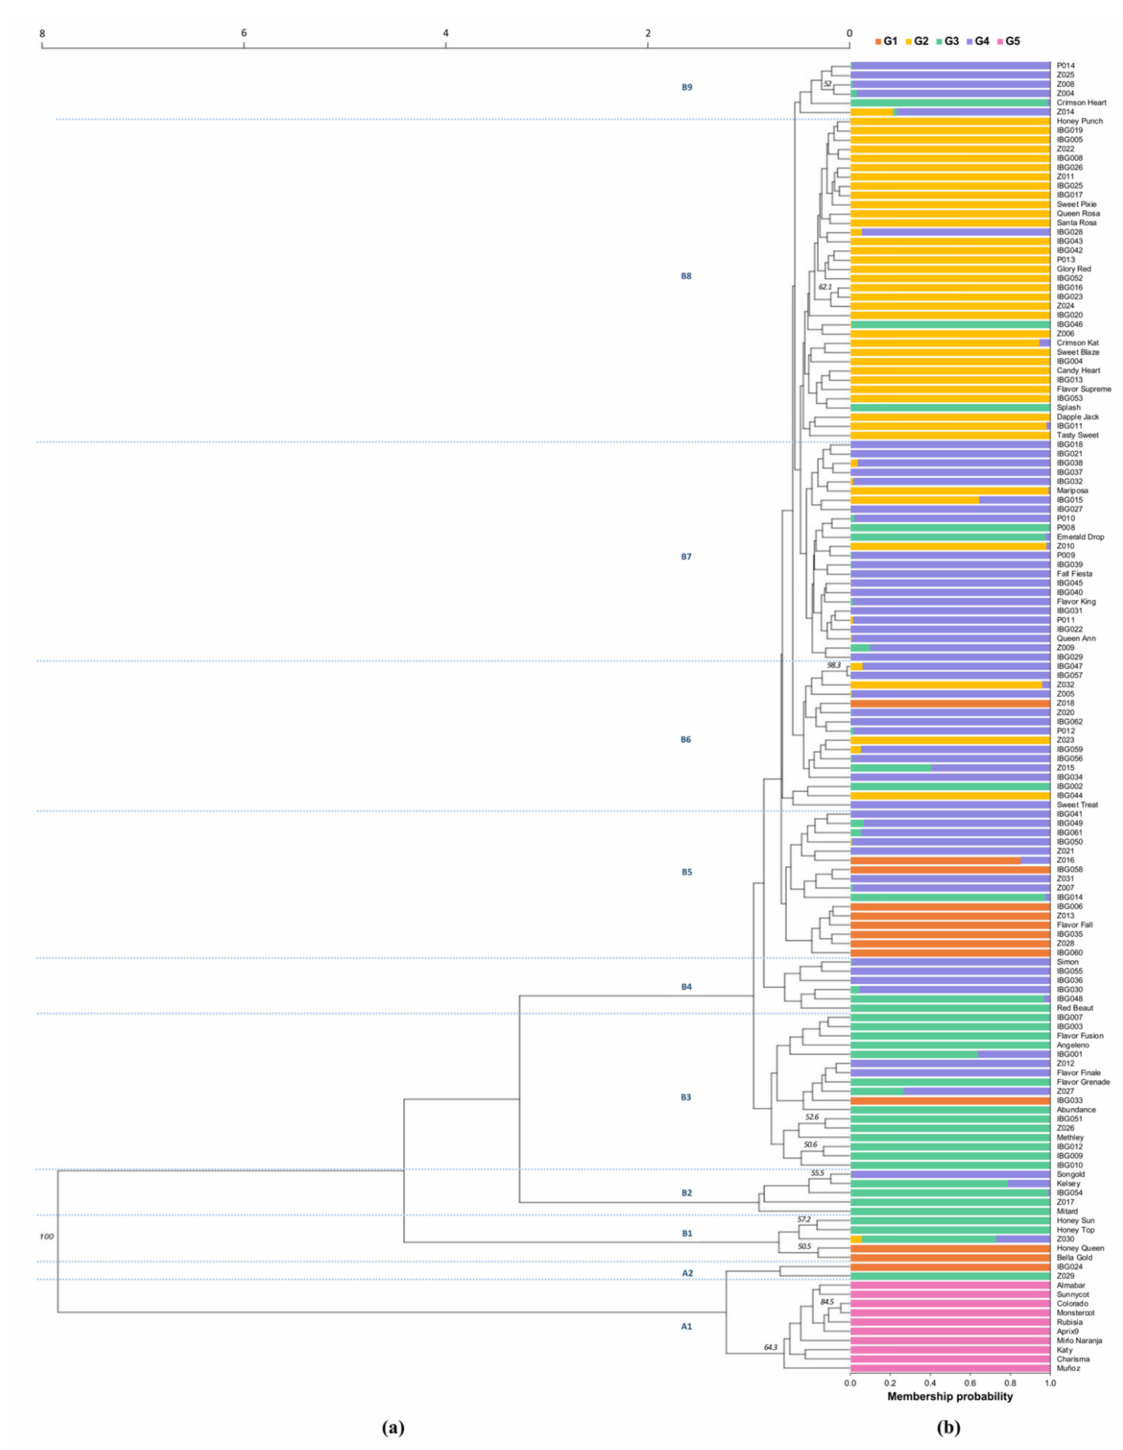
Figure 1. Genetic relationships and population structure from 115 interspecific plum × apricot hybrids and 27 reference genotypes (diploid plums and apricots). ( a ) The genetic relationships are represented by an unweighted pair group method based on arithmetic averages (UPGMA) dendrogram created from 1000 bootstrap replications. Bootstrap values >50% were placed on the branches. ( b ) The population structure is represented by the stacked bar chart. The x -axis provides the probability of each accession belonging to the assigned group identified by discriminant analysis of principal components (DAPC) ( K = 5). These groups are depicted in orange (G1), yellow (G2), green (G3), purple (G4), and pink